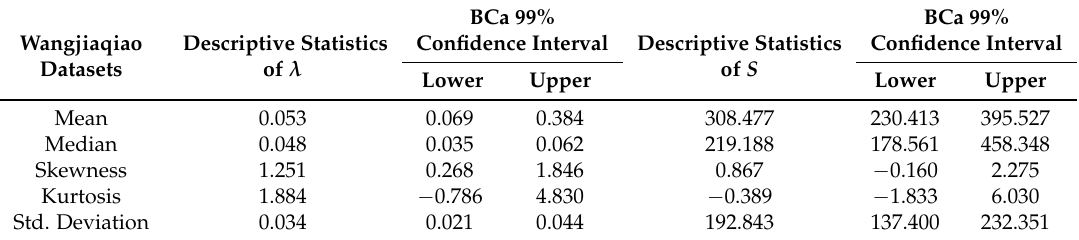
Table 2. Descriptive Statistical Results of λ and S at Bias Corrected and Accelerated (BCa) 99% Confidence Interval. Wangjiaqiao Descriptive